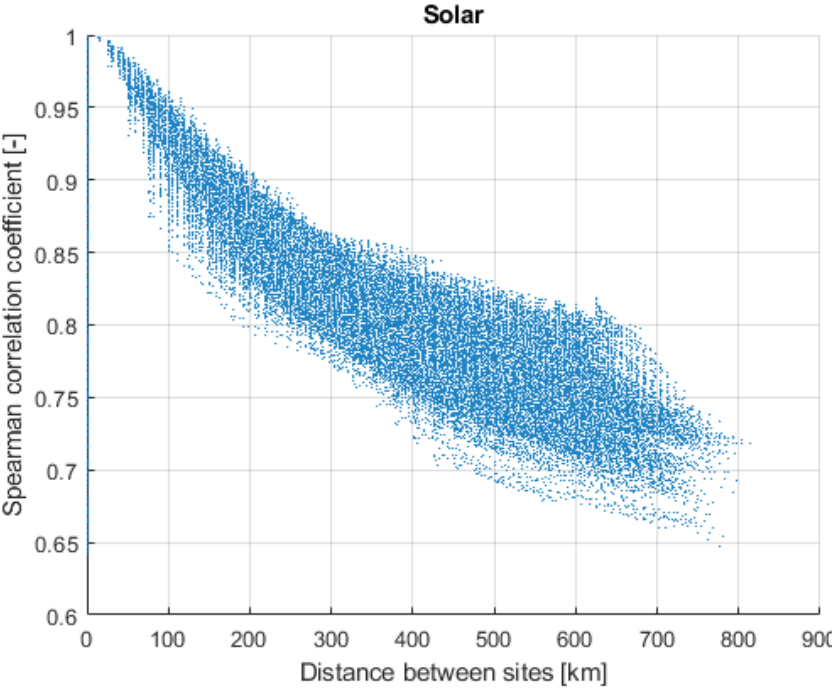
Figure 15. Spatial smoothing (decorrelation) for solar resources across Poland based on hourly time series, 1980 – 2019.